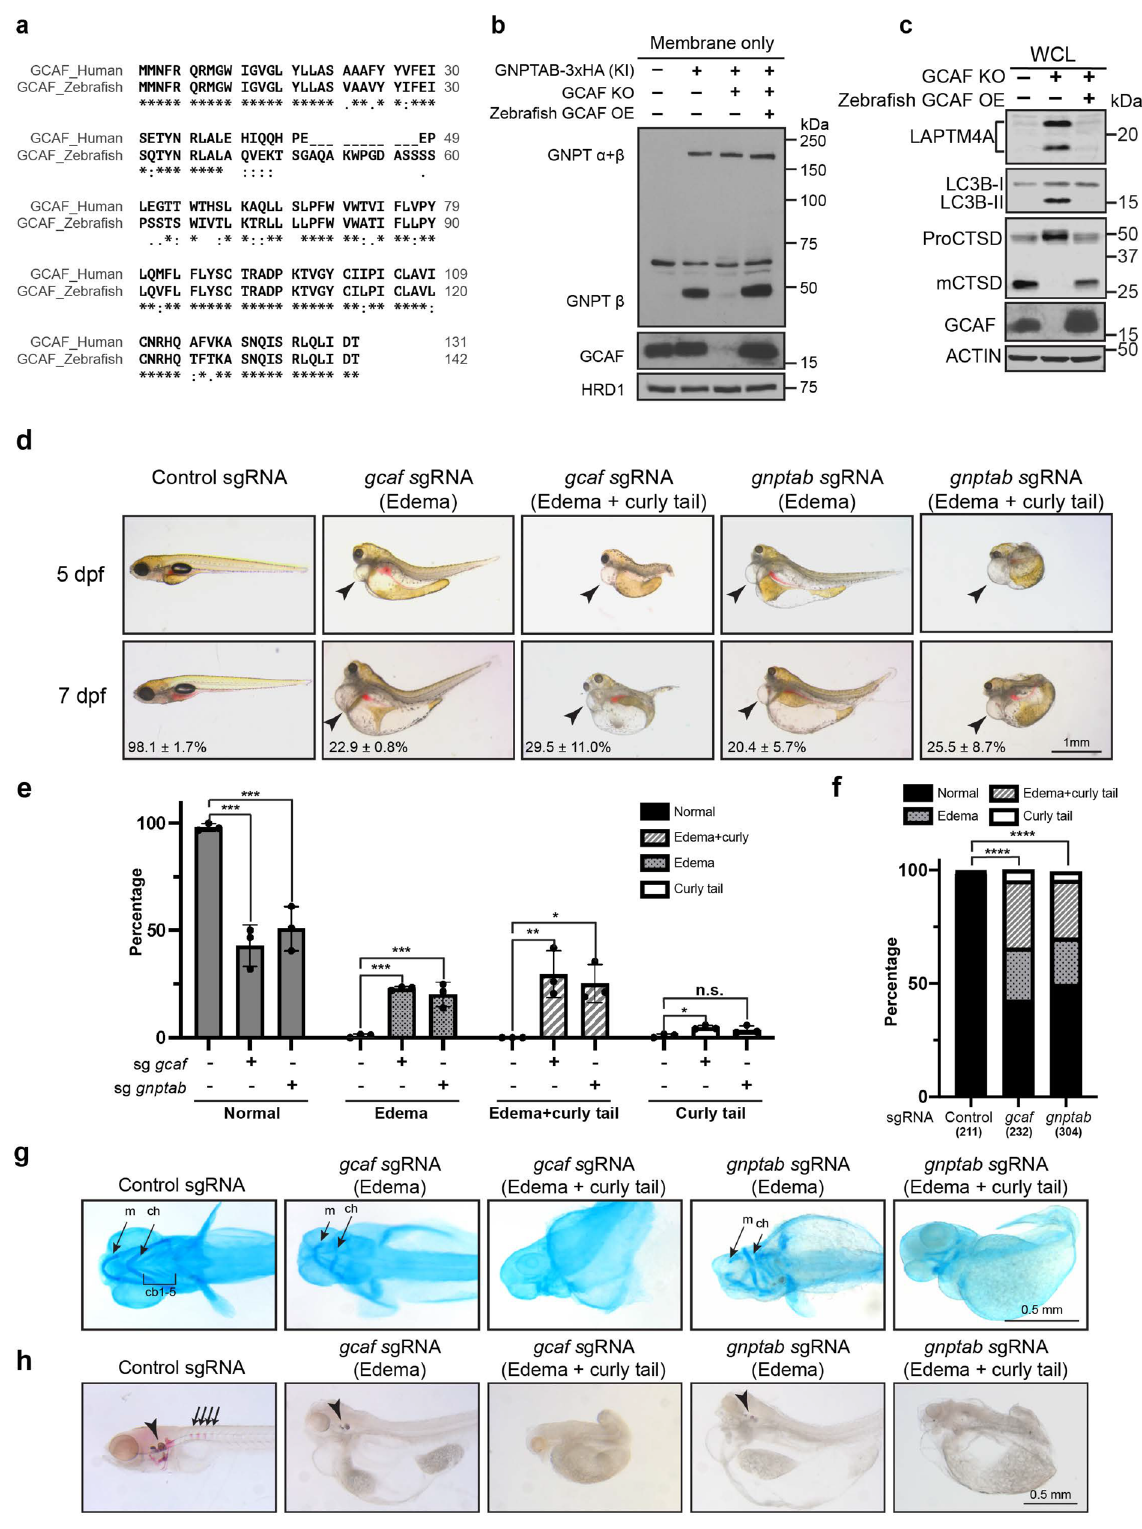
Fig. 7 | GCAF de fi ciency phenocopies ML-II in vivo. a Sequence alignments of human GCAF short isoform and zebra fi sh GCAF. b Zebra fi sh GCAF rescued the GNPTAB processing defects in GCAF KO HEK293T cells ( n =3 independent repli- cates). c Zebra fi shGCAFrescuedthelysosomefunctioninGCAFKOHEK293Tcells ( n =3 independent replicates). d Morphology of the F0 GCAF and GNPTAB de fi - cient fi sh at 5 and 7dpf. Arrowheads point to heart edema. e Quanti fi cation of morphological phenotypes observed in d . Mean of 3 independent replicates is